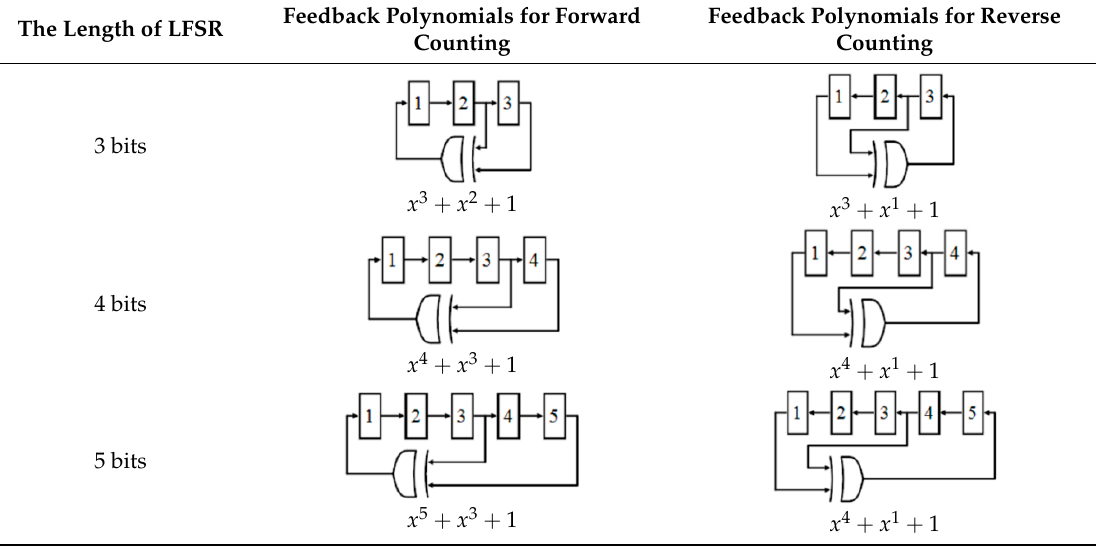
Table 1. Forward and reverse linear feedback shift register (LFSR) with three different sizes (the rectangles stand for D flip-flops).